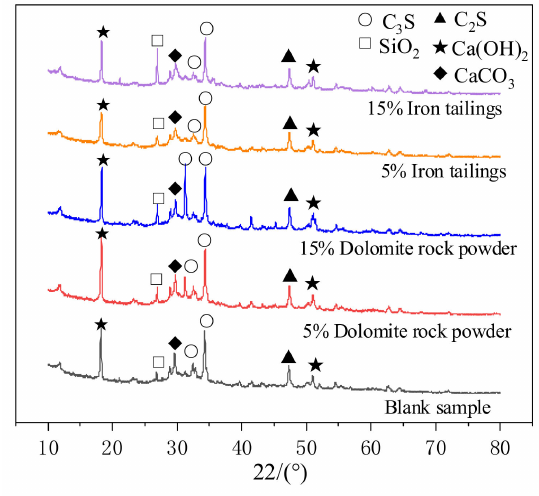
Figure 7. X-ray diffraction patterns of